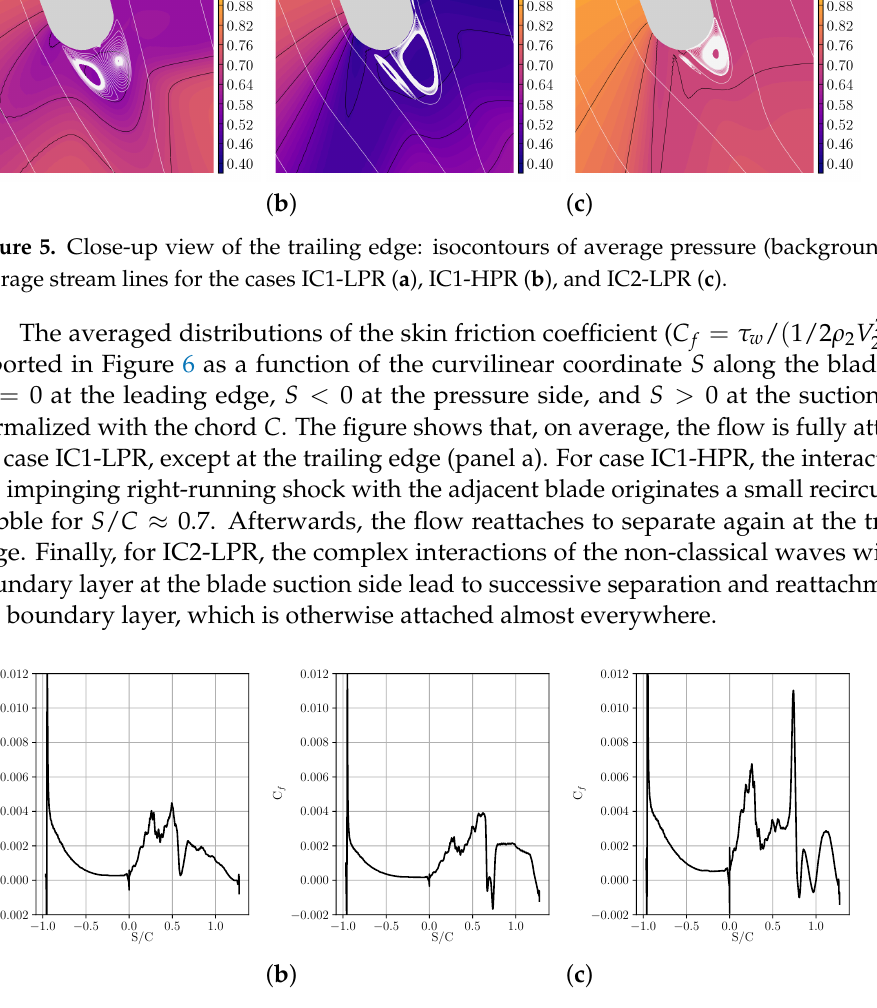
Figure 6. Wall distributions of the averaged skin friction coefficient for IC1-LPR ( a ), IC1-HPR ( b ), and IC2-LPR ( c